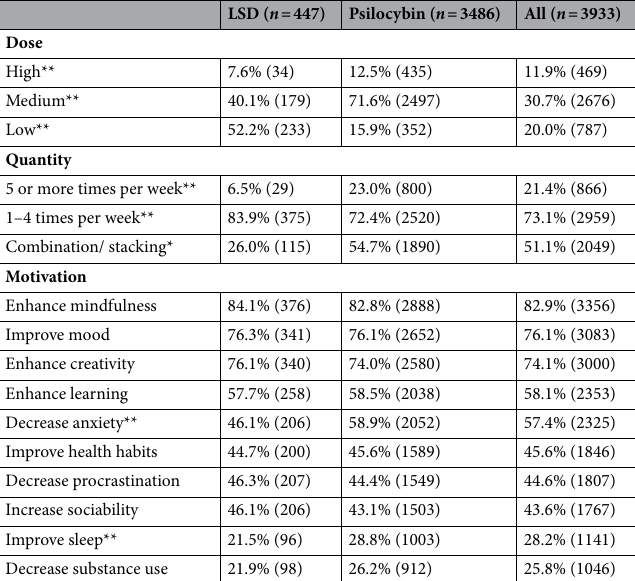
Table 4. Microdosing practices. On variables with missing data, percentages reflect proportions of the total valid, non-missing, responses within a category. * p < 0.05, **p <